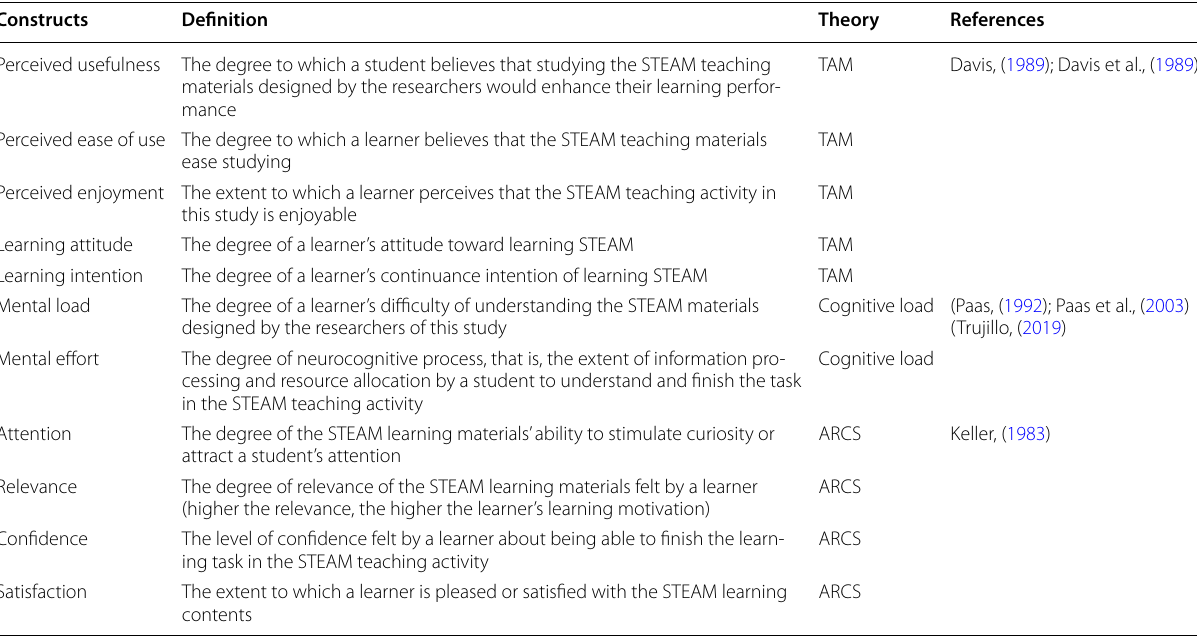
Table 1 Model constructs, definitions, and